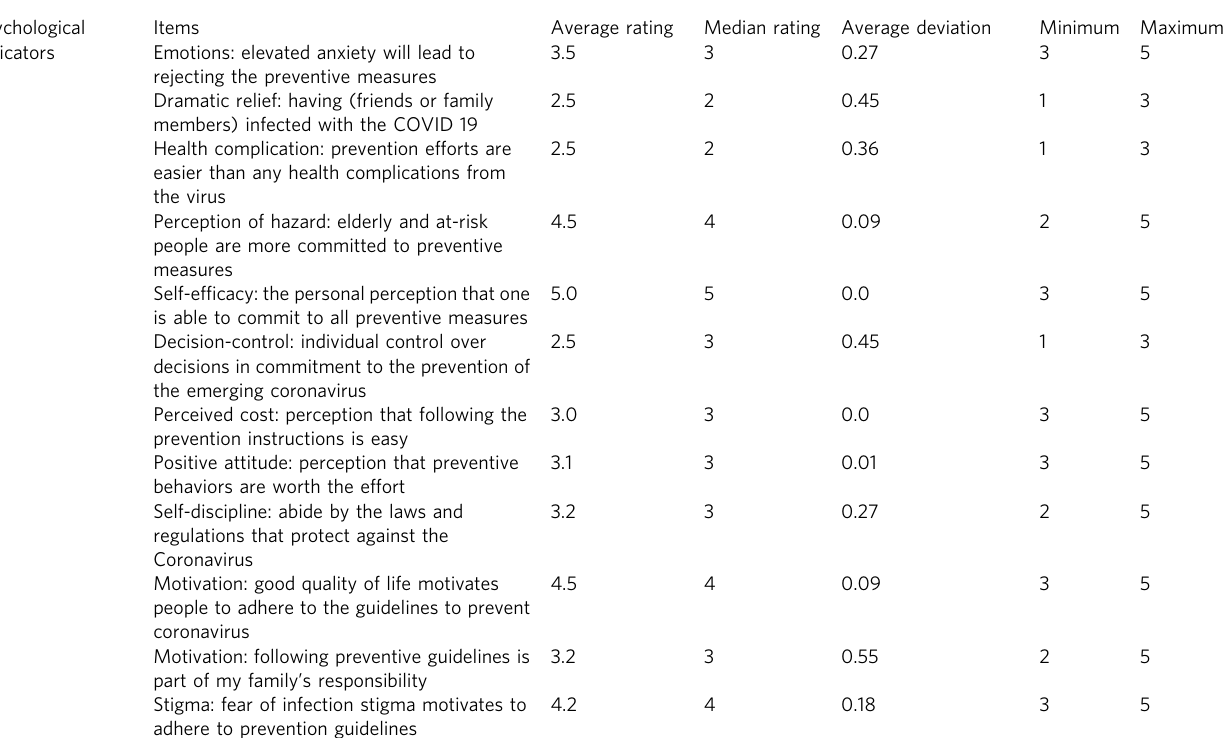
Table 3 The psychological indicators of individual Covid-19 preventive behavior. Psychological Items Average rating Median rating Average deviation Minimum Maximum indicators Emotions: elevated anxiety will lead